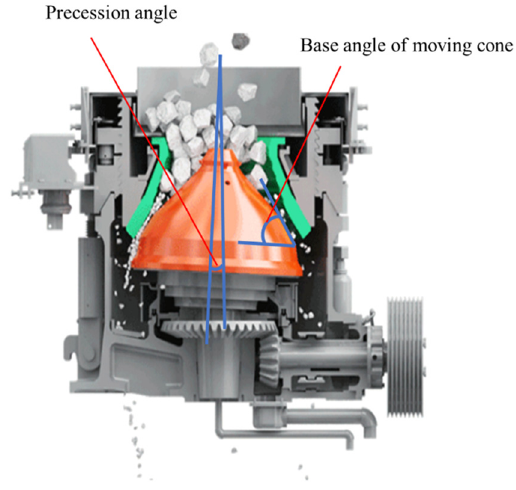
Figure 5: Diagram of moving cone